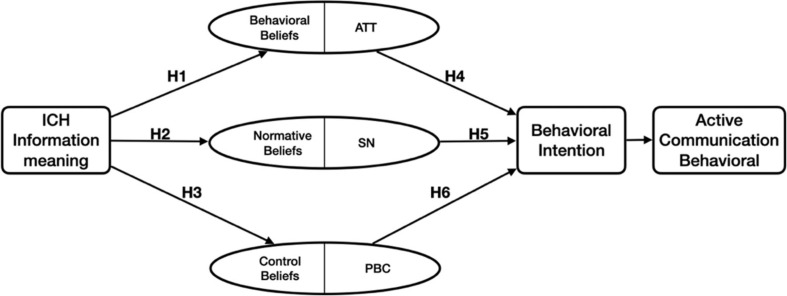
Research framework.